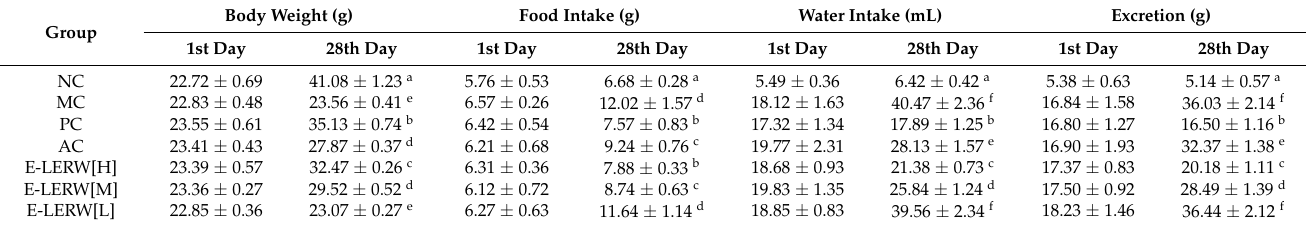
Table 2. Body weight, food intake, water intake, and excretion of mice treated with astilbin and E-LERW. Body Weight (g) Food Intake (g) Water Intake (mL) Excretion Group